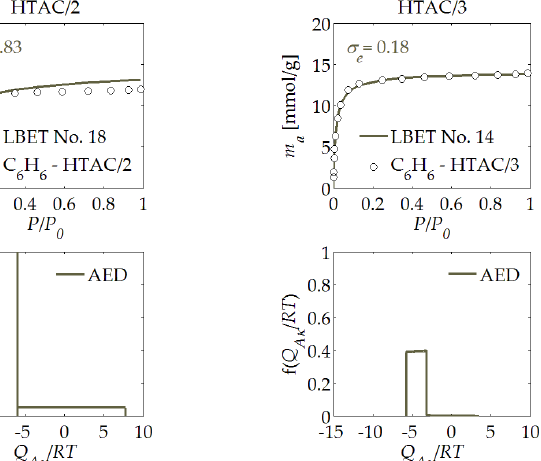
Figure 5. The same as Figure 1, but for the HTAC/ R activated carbon derived from hazelnut shells.